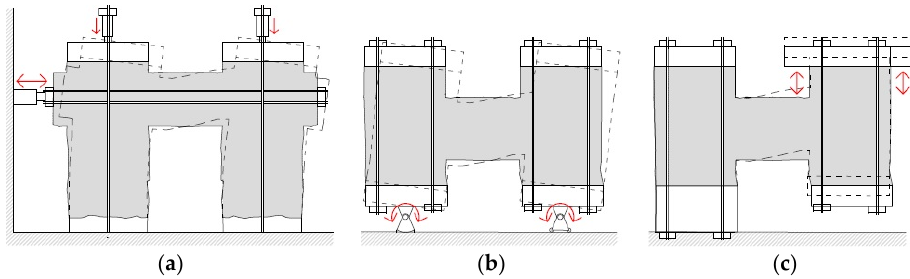
Figure 4. Schematization of ( a ) TT-shape and ( b , c ) H-shape setups for cyclic tests on spandrels.